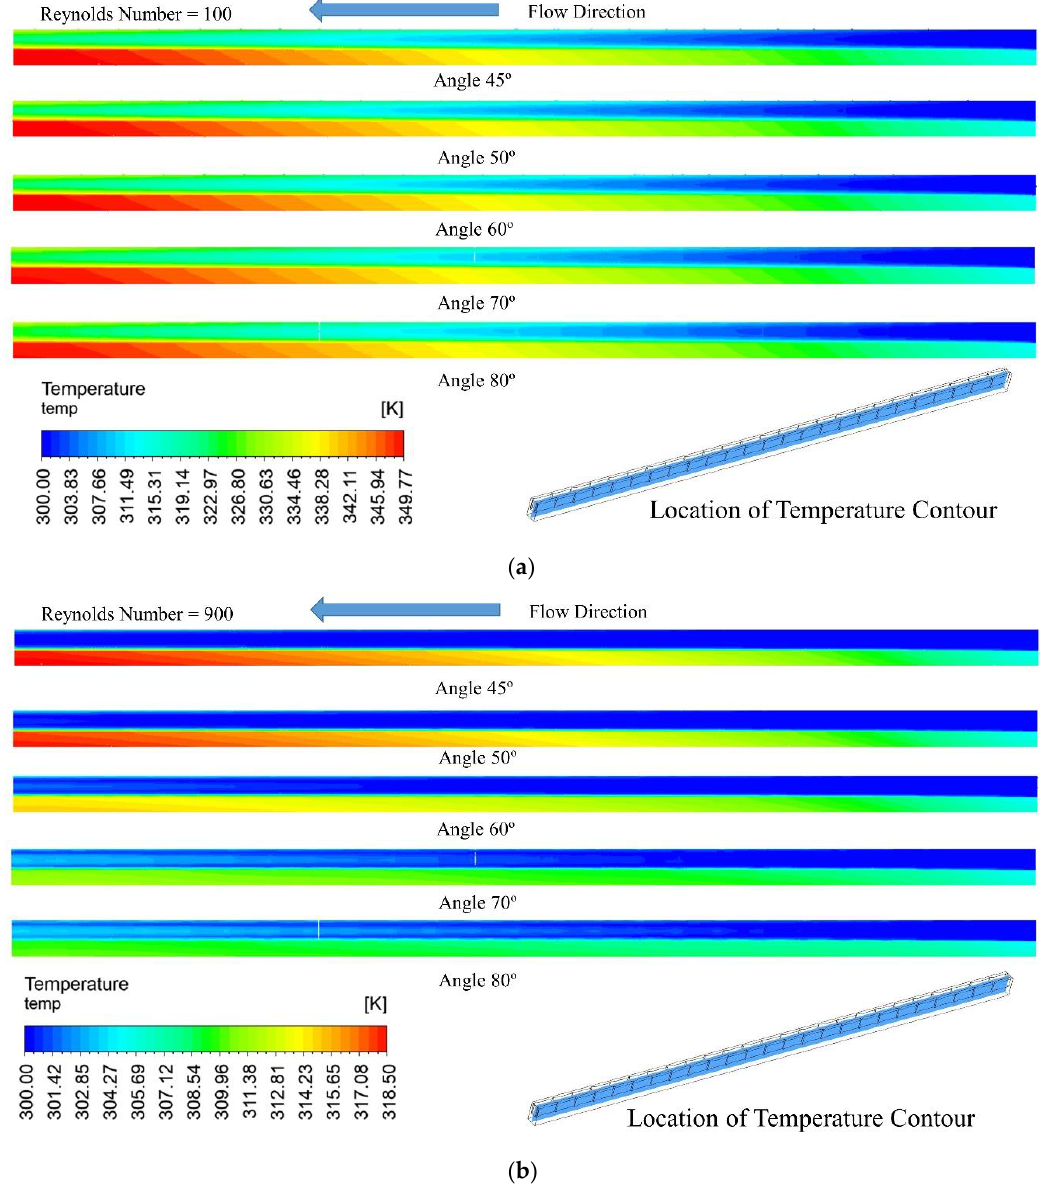
Figure 7. Temperature profile at the mid plane of the microchannel and fluid domain at ( a ) Re = 100 and ( b ) Re = 900.